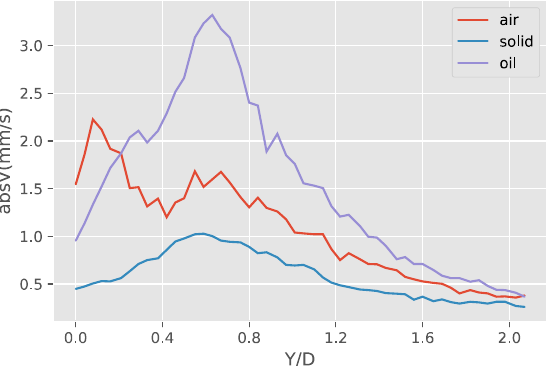
Figure 15. The absolute velocity profile averaged over the X -axis along the Y -axis of the three obstructions.